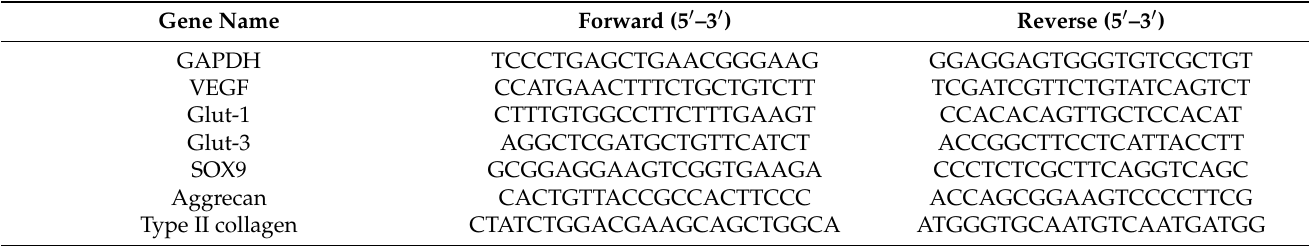
Table 1. qRT-PCR genes and primer